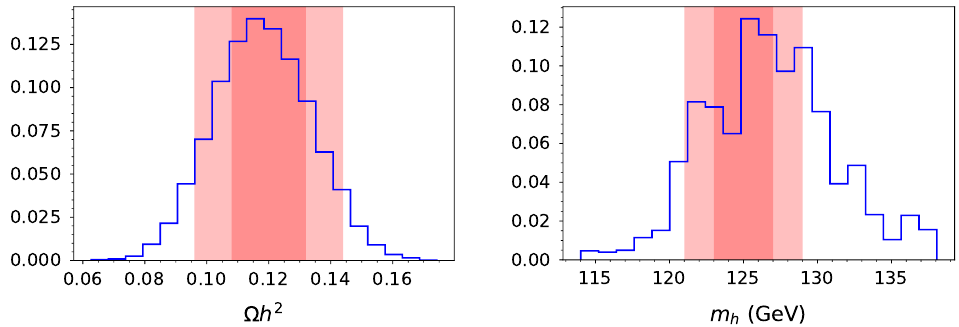
Figure 3 . Distribution of the Higgs mass and dark matter relic density predictions, normalised to one. The 1 σ ( 2 σ ) region is marked in red (light red). The MCMC displays an approximate Gaussian fit around the experimental